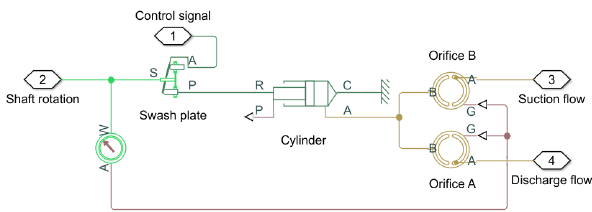
Figure 8: Flow modelling of a single piston using Sim- scape components